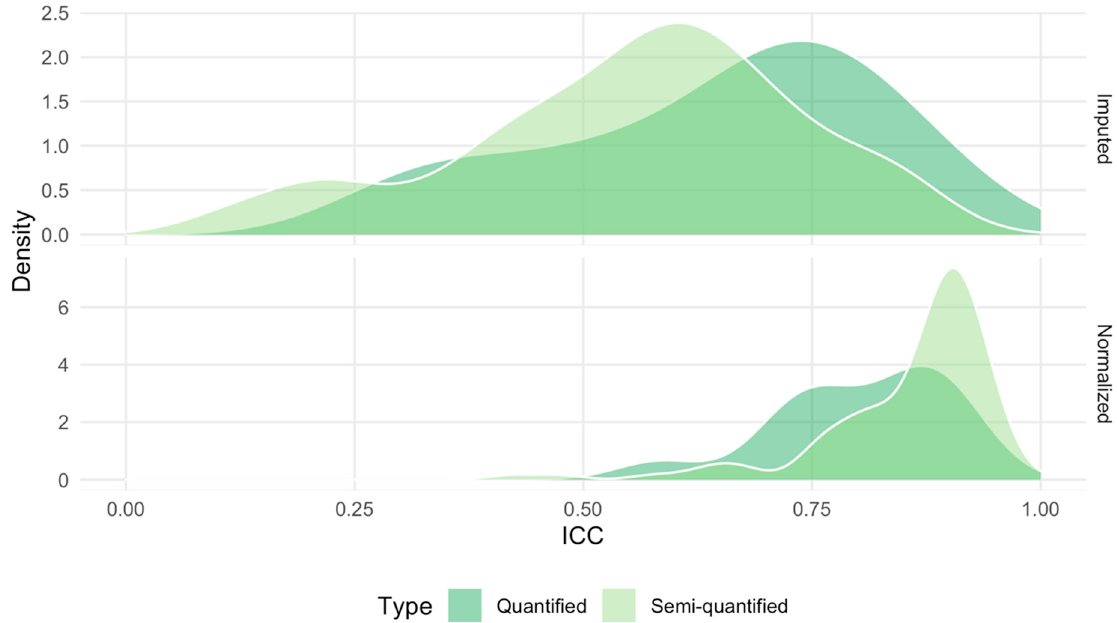
Figure 4. Distribution of the intraclass correlation coefficient (ICC) for quantified and semi-quantified metabolites, before ( top ) and after ( bottom ) normalization. In each plot, the x –axis represents the value of the ICC and the y –axis the value of the estimated density.